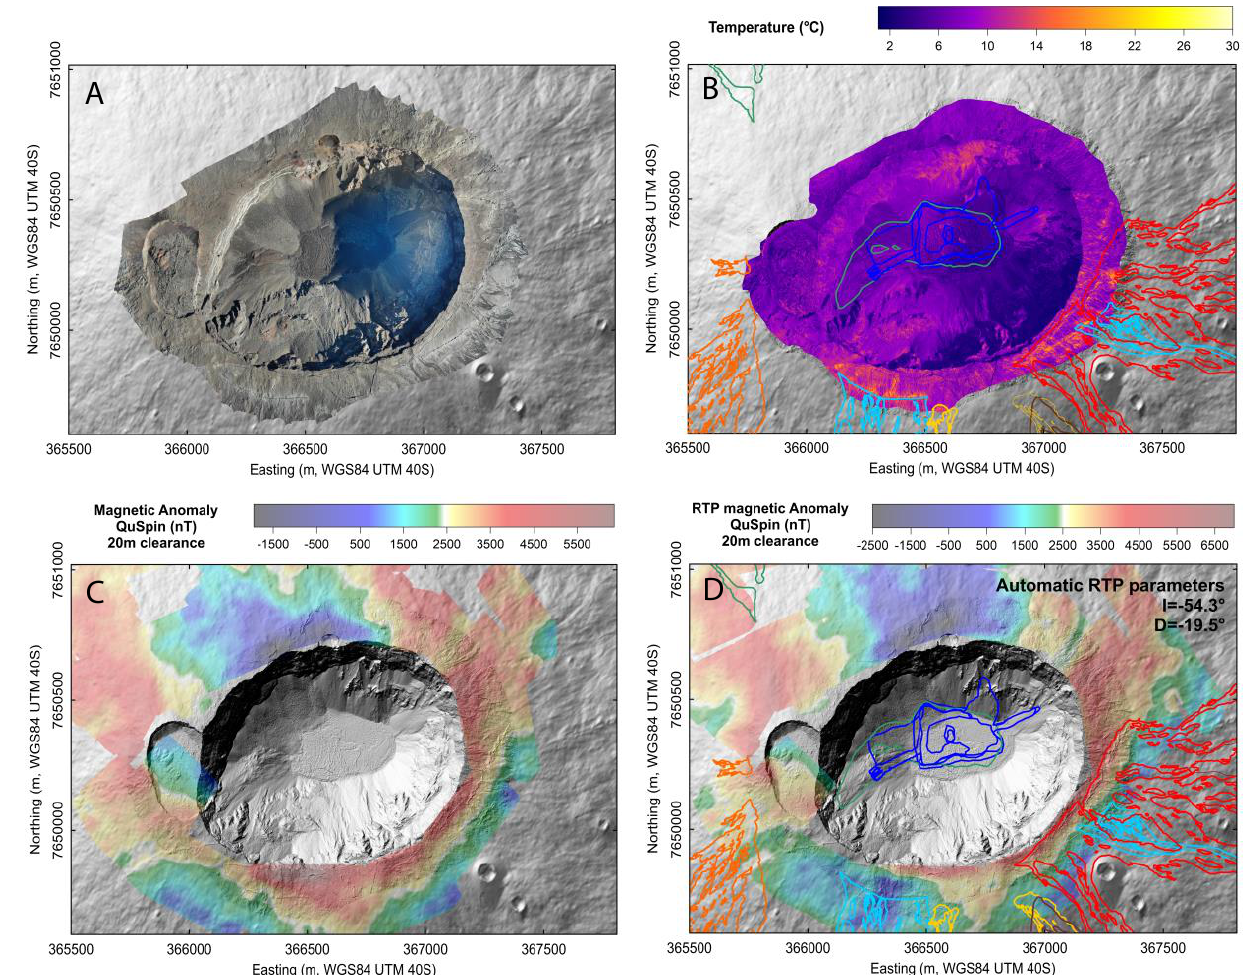
Figure 3: Multi-method UAV imaging of the summit area of Piton de la Fournaise. [A] Orthophoto. [B] Thermal IR image corrected for ground heating. [C] Maps of the magnetic anomalies, and [D] Reduced to the pole (RTP) magnetic anomalies. For insets [B] and [D], the color code for the contours of the lava flows is the same as in figure 1.